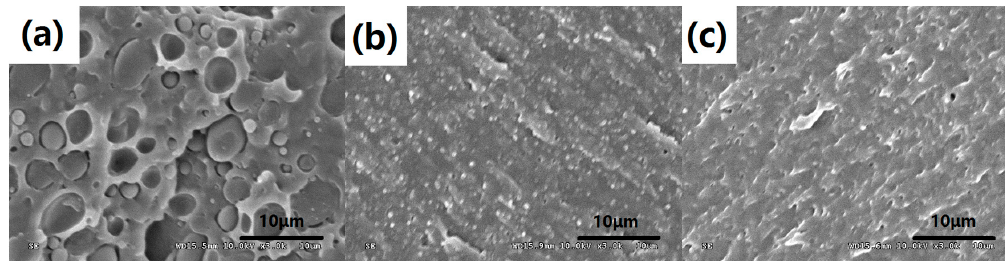
Figure 9. SEM micrographs of PLA/TPEE/ADR samples annealed at 80 °C for 40 min: ( a ) PLA/TPEE (80/20); ( b ) PLA/TPEE/ADR (80/20/0.5); ( c ) PLA/TPEE/ADR (80/20/1.0).